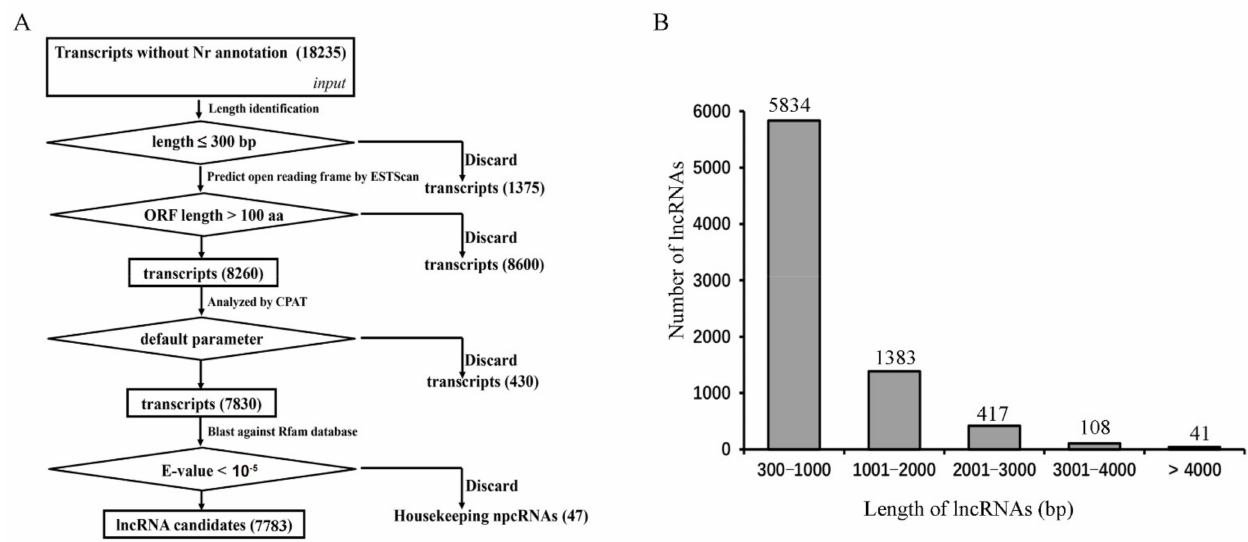
Figure 4. The schematic pipeline and size distribution of lncRNAs. ( A ) Predicted pipeline of lncRNA candidates. ( B ) Size distribution of lncRNA